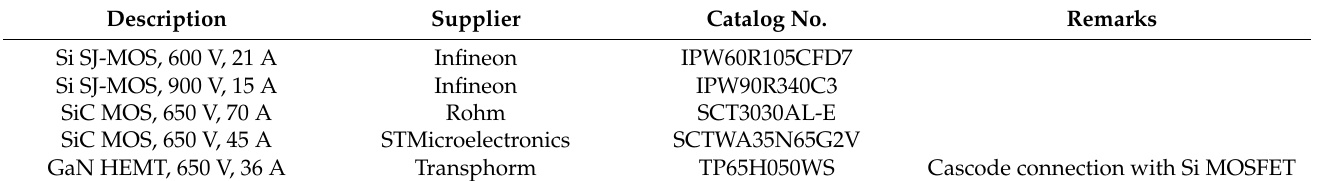
Table 1. List of tested power switches.